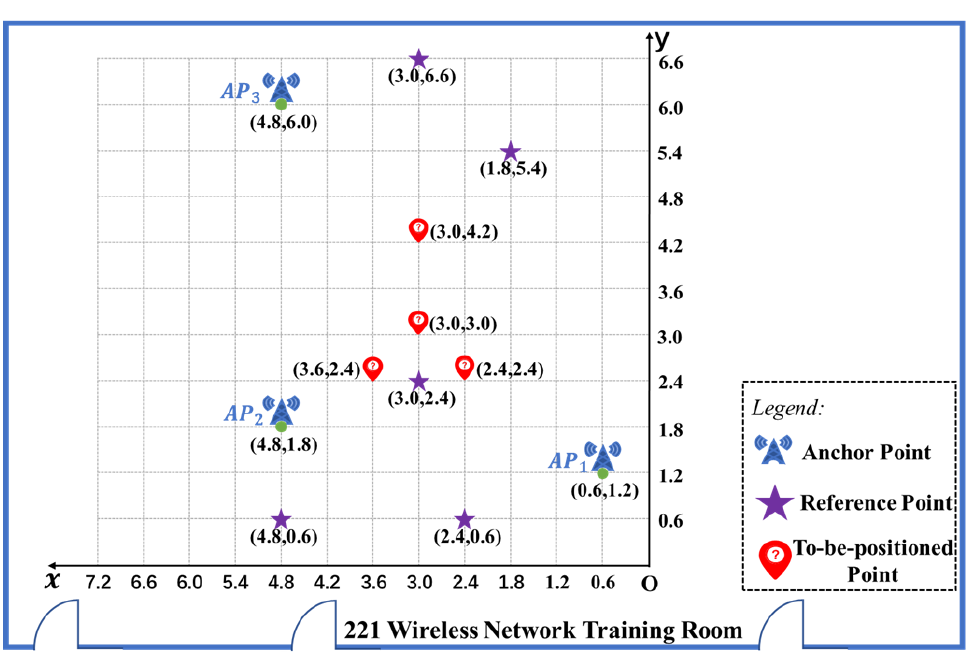
Figure 3. Experimental scene distribution